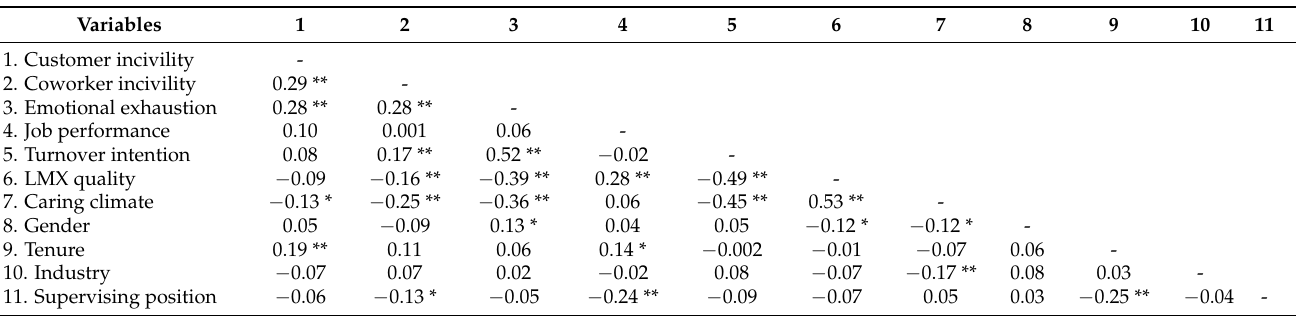
Table 2. Pearson correlation coefficients between the study variables ( n =